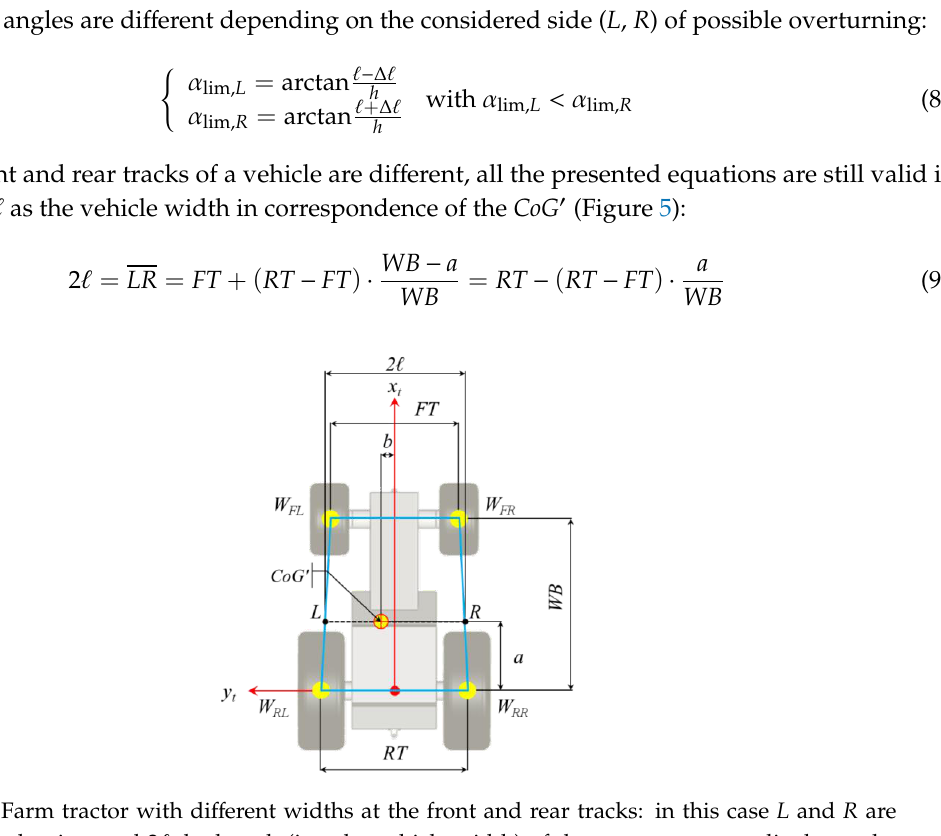
Figure 6. Placement of the tractor frame of reference.